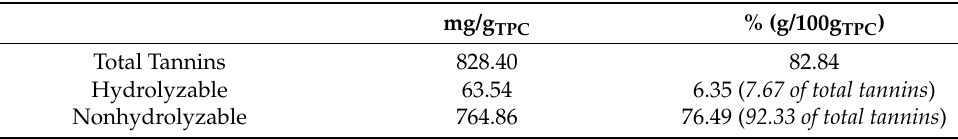
Table 5. Total tannin quantification and composition (hydrolyzable and nonhydrolyzable) in SWE chestnut extract.